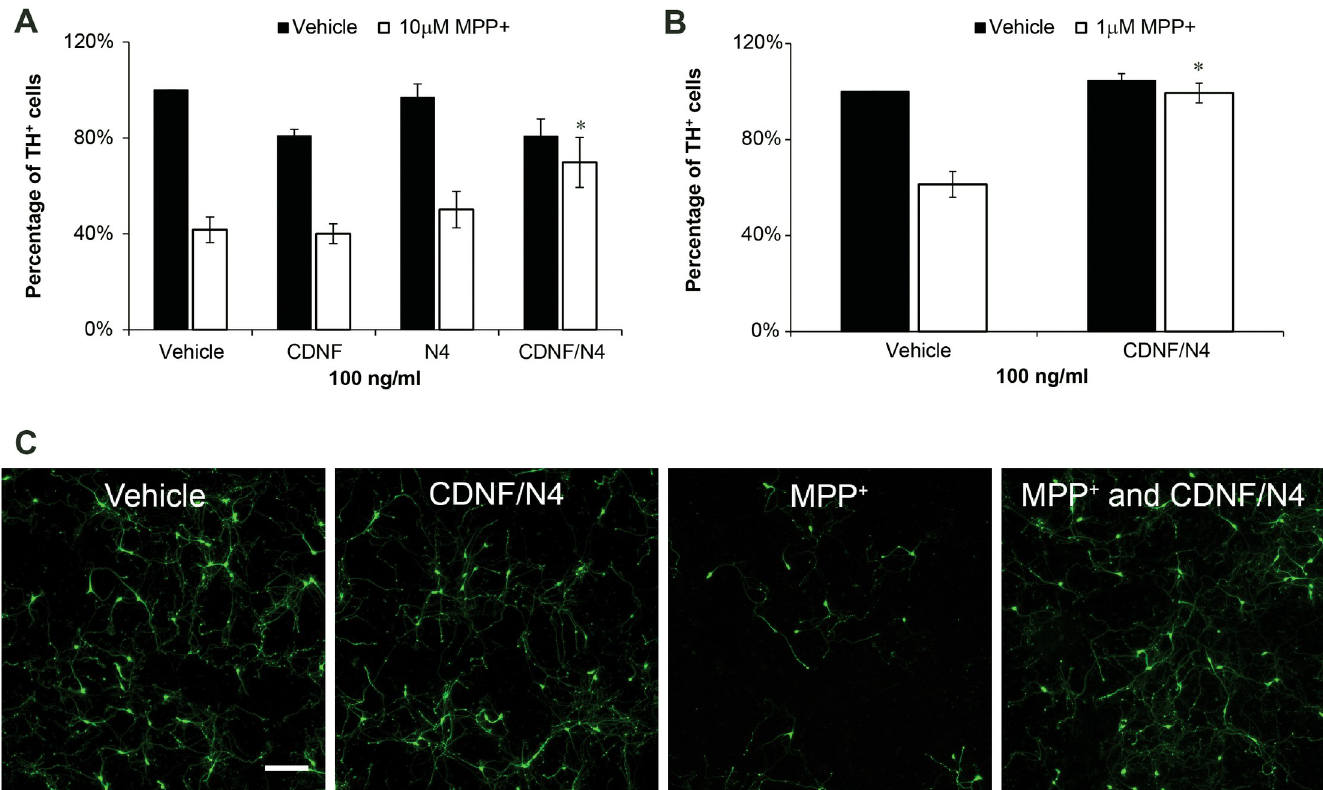
Fig 3. Protection of DA neurons as indicated by TH isolated from the SN from MPP + . 100 ng/ml of CDNF and N4 present 1hr before and for 48 hr after MPP + exposure had a protective effect of the survival of DA neurons. (A) Neither CDNF nor N4 individually had a significant effect on TH + cells survival. However, when the two NTFs were added together the number of TH + cells increased by 28.2 ± 10.5% against 10 μ M MPP. (B) The combination of CDNF and N4 completely protected DA neurons against 1 μ M MPP + ( � = p < 0.05 two-way ANOVA followed by post hoc test with Bonferroni correction on data normalized to the vehicle control, n = 3 or 4 experiments per condition). (C) Representative images of immunostaining of DA neurons for TH (green) in vehicle treated and CDNF/N4 (100 ng/ml of each) in the presence or absence of 10 μ M MPP + . The scale bar indicates 200 microns.